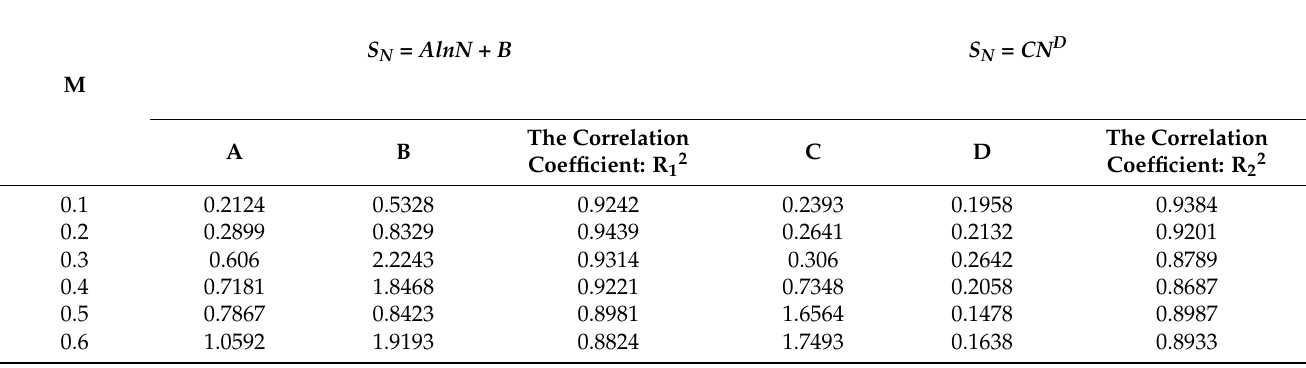
Table 3. The S N – N conventional fitting curve parameters.